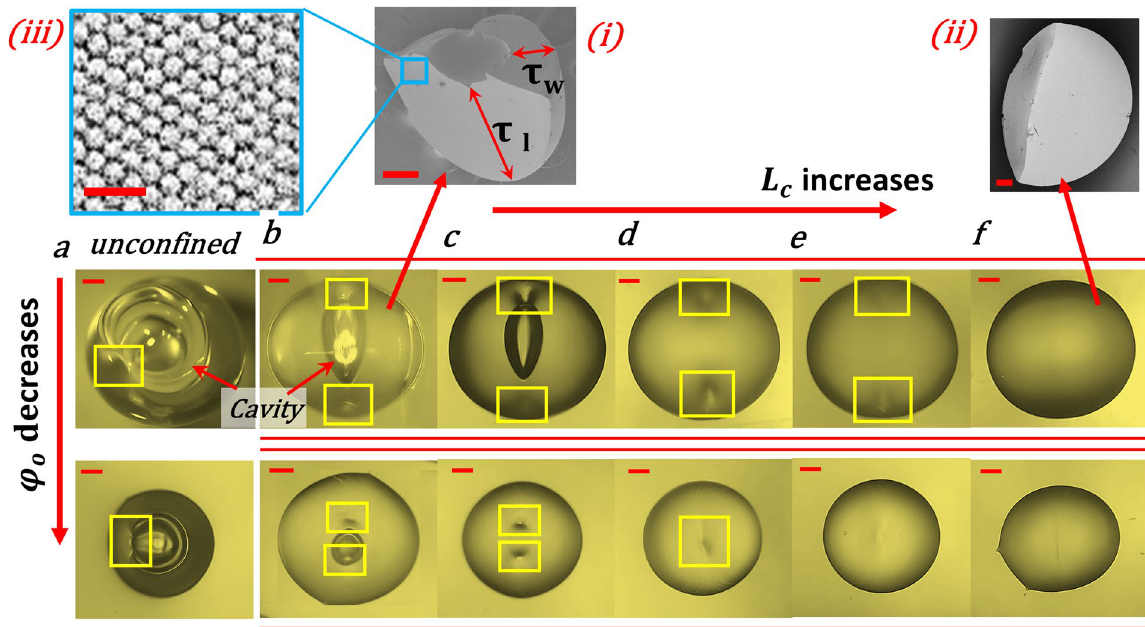
Figure 4. Decrease in buckling tendency. Droplet morphology showing droplet final structures (top view) for ( a ) unconfined case ( b – f ) confined cases with L c = ( b ) 5 mm ( c ) 7 mm ( d ) 10 mm ( e ) 15 mm ( f ) 20 mm. Images shown in second row correspond to same confinements with ϕ o = 15 wt .% whereas first row ϕ o = 40 wt .%. ( a ) Buckling and subsequent rupturing is observed in top sector of the droplet irrespective of concentration. ( b – e ) For ϕ o = 40 wt .% buckling locations are shifted to the wall sides. ( b , c ) Buckling is followed by rupturing, ( d – e ) only buckling is observed ( f ) buckling is completely suppressed with a dome shaped structure. For confined cases with 15wt.%, buckling locations shift back to the top sector. Inset (i) and (ii)-SEM micrographs of the final precipitates for channel length L c = 5 mm and 20 mm respectively. τ l and τ w correspond to the aggregate thickness on the exposed portion and wall side respectively. (iii) SEM micrograph showing the final particle arrangement. Yellow boxes denote the buckling locations and large red horizontal lines represent the channel walls. Scale bar equals 200 µ m. Scale bar in the inset (i) and (ii) equals 100 µ m while in (iii) equals 60